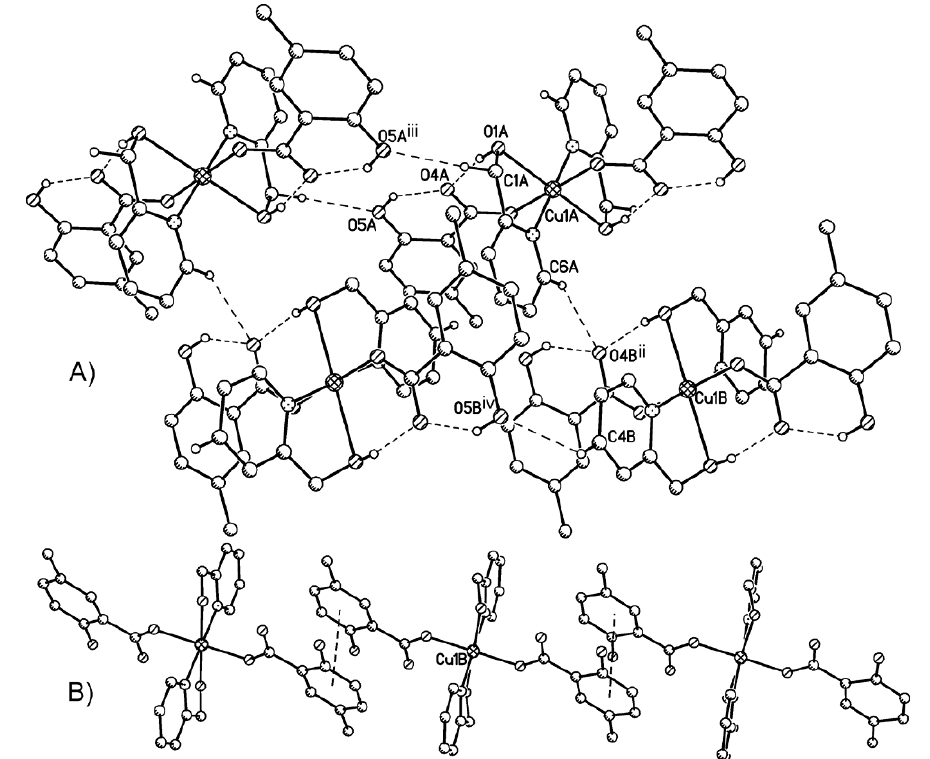
Figure 5. Crystal packing of [Cu(5-Mesal) (2-pyme) ] (5) . Hydrogen atoms are omitted for clarity. A) The O—H···O and C—H···O hydrogen 2 2 bonds in crystal structure of 5 . B) The π – π stacking interactions between benzene rings of 5-methylsalicylate anions.